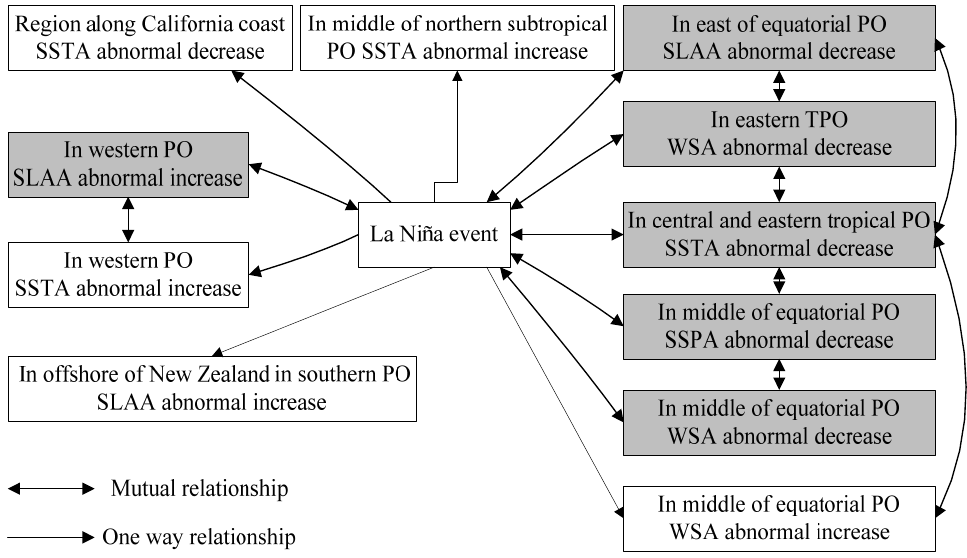
Figure 5. Association patterns network for La Niña events and marine environmental parameters. The mutual relationship between X and Y ( (cid:1850) ↔ (cid:1851) ) means that X has enough information to tell Y occurrences, and meanwhile, Y has enough information to tell X occurrences, which are shaded in gray boxes. The one-way relationship from X to Y ( X → Y ) means that X has enough information to tell Y occurrences.